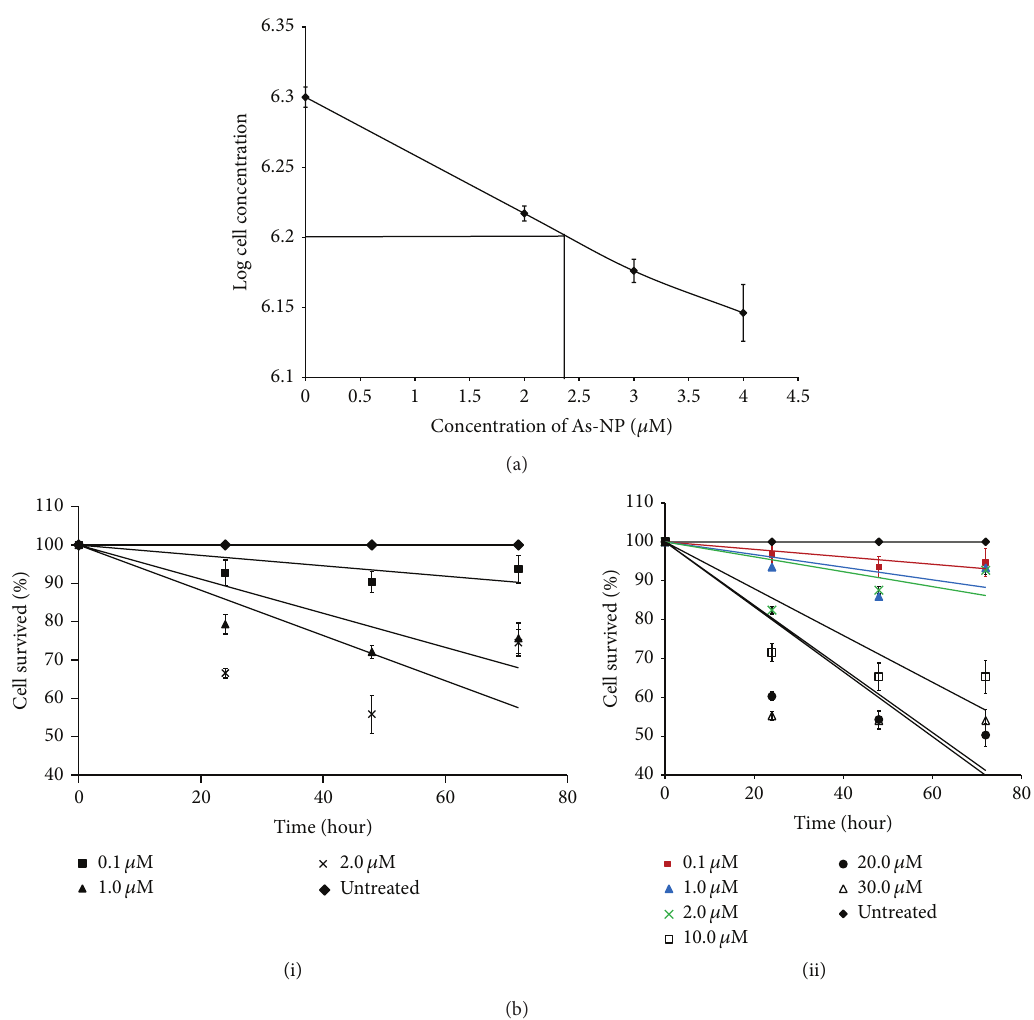
Figure 1: Cytotoxicity assay of Leishmania promastigotes by As-NPs and As (III). (a) Determination of IC 50 value from the plot of log of promastigote cell numbers obtained after 24 hours of incubation with indicated concentrations of As-NPs. The error bars indicate SEM. (b) (i) The percentage of cell survival of Leishmania promastigotes treated with 0.1 𝜇 M ( ◼ ), 1.0 𝜇 M ( 󳵳 ), and 2.0 𝜇 M ( × ) As-NPs for 24, 48, and 72 hours and those left untreated ( X ) for the same time period was measured by MTT assay as mentioned in Section 2. The error bars indicate SEM. (b) (ii) The percentage of cell survival of Leishmania promastigotes treated with 0.1 𝜇 M (red line), 1.0 𝜇 M (blue line), 2.0 𝜇 M (green line), 10.0 𝜇 M ( ◻ ), 20.0 𝜇 M ( e ), and 30.0 𝜇 M ( 󳵻 ) As (III) for 24, 48, and 72 hours and those left untreated ( X ) for the same time period was measured by MTT assay as mentioned in Section 2. The error bars indicate